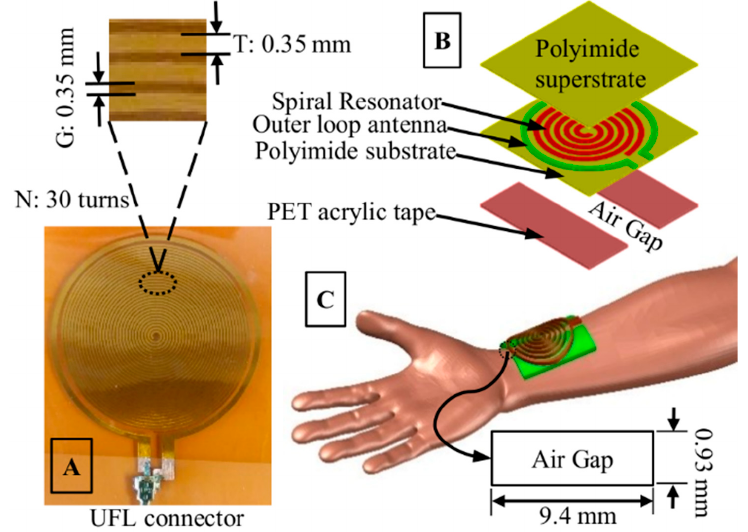
Figure 1. The proposed resonator design illustrating ( A ) the number of turns, N = 30, trace width, T = 0.35 mm, gap width, G = 0.35 mm, and diameter, d = 30 mm of the planar spiral structure. ( B ) shows the exploded view of the resonator, and ( C ) shows the placement of the sensor on the radial location with approximate air gap dimension. Unlike our prior works [1,5], the designed structure includes an empirically tuned air gap of 9.4 × 0.93 mm surrounded by 0.94 mm thick PET acrylic tape (Figure 1C). We have found that at around the HF band (30–40 MHz), traditional instrumentations using benchtop equipment and off ‐ the ‐ shelf components cannot register the RF carrier modula ‐ tion resulting from pulsatile blood flow using the spiral resonator. We hypothesize that the impedance variations due to blood flow at the resonator–tissue interface are tiny enough to be detected and exist within the noise floor of the measuring equipment. In our modified resonator, the inclusion of the air gap adds a variable coupling capacitor at the interface between the resonator and the tissue elements. Therefore, this coupling capacitor becomes a tuning element of the lumped impedance matching circuit when the resonator– tissue system is at resonance. We hypothesize that this coupling capacitance can be influ ‐ enced significantly due to the change of effective permittivity of the dielectric medium. During blood flow and nearfield perturbation, this added air capacitance results in RF carrier modulation detected by the designed wearable readout system. Figure 2b shows a lumped RLC (here, R—resistance, L—inductance, C—capacitance) circuit model of a skin coupled resonator. Here, L1 models the resonator’s impedance in the air, determined from the m1 point, as shown in the smith chart in Figure 2a. The smith chart values were obtained using a single port measurement from a vector network ana ‐ lyzer (Model: R&S ZNC ‐ 3). All the impedance measurements were measured concerning 50 ‐ ohm port impedance. The impedance ‐ matching network consisting of L2 and C2 ap ‐ proximates the resonator’s S 11 response over the skin. Figure 2c shows the resonator’s S 11 response over the skin and from the circuit model described in Figure 2b. The lumped model’s S 11 response is computed without including the air gap capacitance, C_air. Here, C_air value is not an absolute value in the sensing system. Rather it delineates the effect on the S 11 parameter of the skin ‐ coupled resonator in the presence of an air gap. From Figure 2c, it is evident that introducing an air gap can shift the band response of the skin ‐ coupled resonator. In practical application, C_air will be modulated by the pulsatile blood flow resulting in RF carrier modulation.